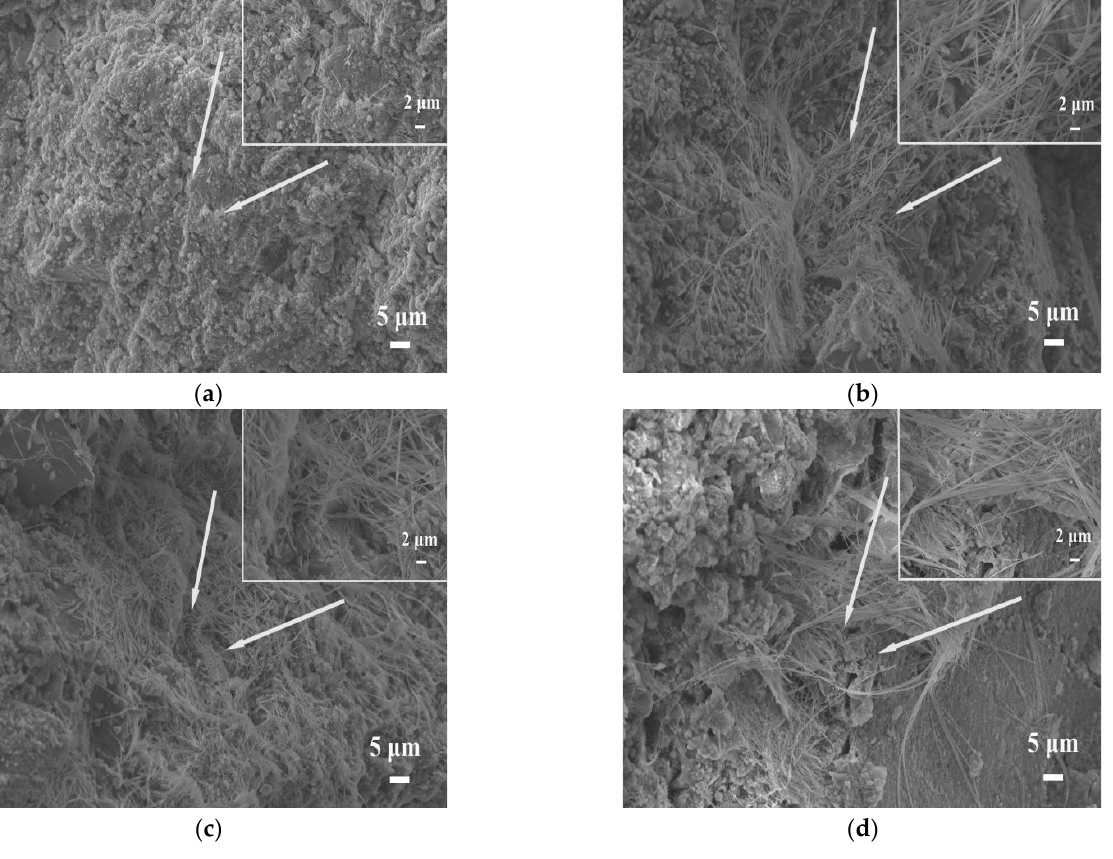
Figure 7. SEM images of mortars: ( a ) Con, ( b ) M10S, ( c ) M20S, ( d ) M30S.